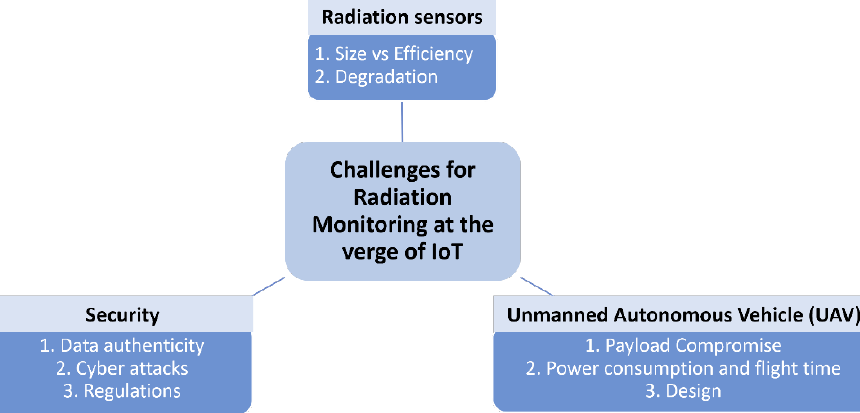
Figure 5. Summary of the challenges of radiation monitoring at the verge of the Internet of Things.